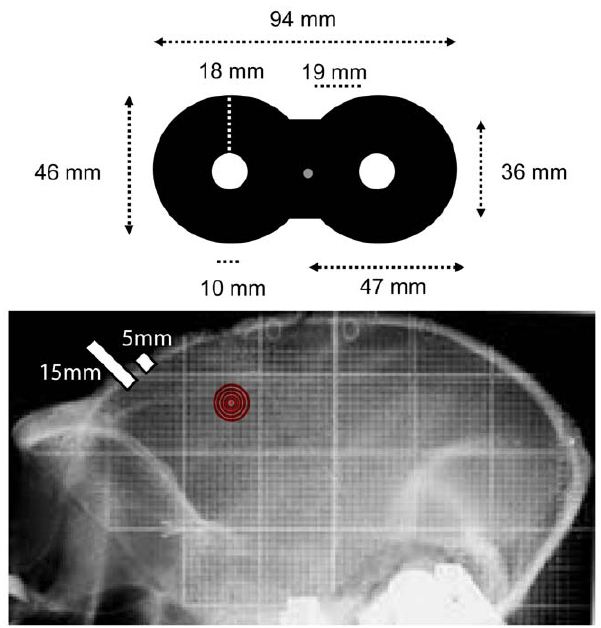
Figure 3. TMS coil positioning. Schematic drawing of the smallest of the commercially available coils, which was used for this experiment ( Upper panel ), a custom-made , 25 mm loop radius figure-of-eight TMS coil (exact dimensions of the coil used indicated in the figure) (Magstim Company, Carmathenshire, Wales). ( Bottom panel) X-rays photography of monkey ‘C’. The red target represents the estimated stereotaxic coordinates of the monkey’s FEF area. The length of the white bar illustrates approximate differences in bone thickness between the human and the macaque skull at frontal locations.